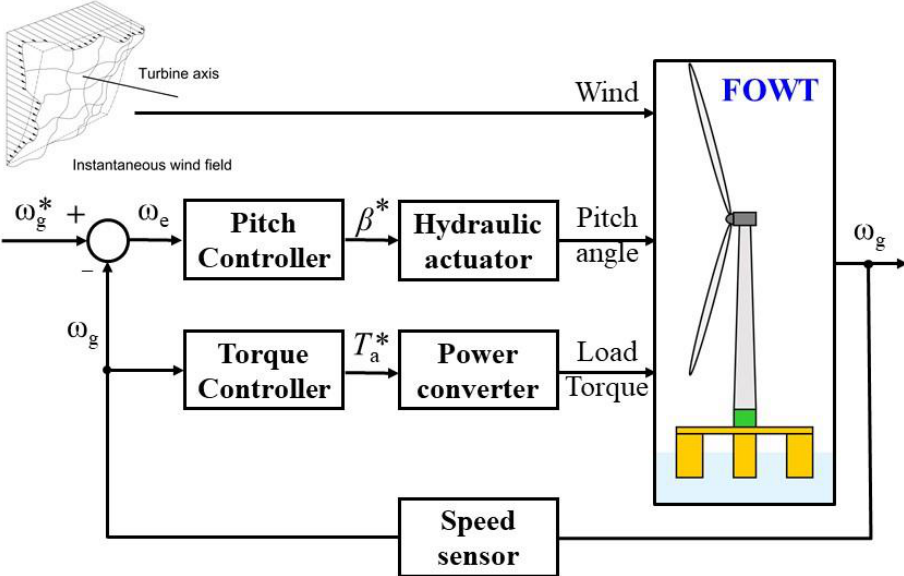
Figure 3. Diagram of overall control system for a floating offshore wind turbine (FOWT) system.